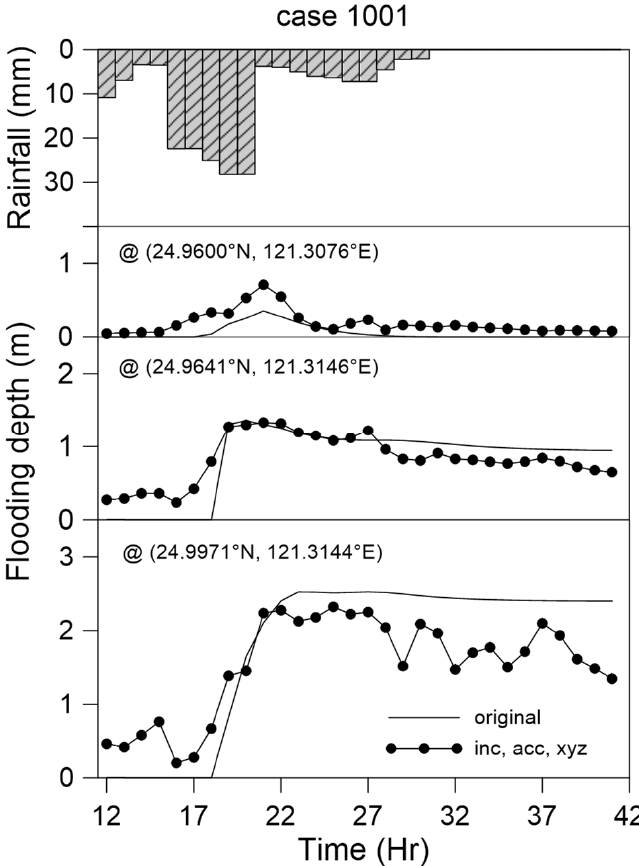
Figure 17. Flooding depth at different locations versus time for a single rainfall event when using the Inception architecture and rainfall data containing XYZ information.